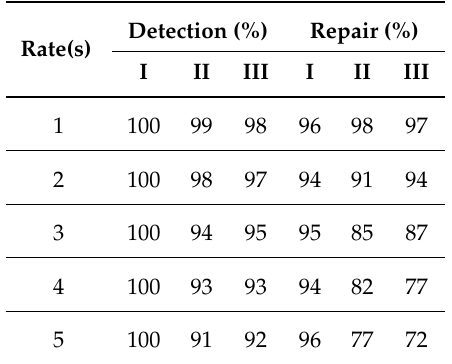
Table 3. The results of detected and corrected of the cycle slip over all stations for the three different methods in case